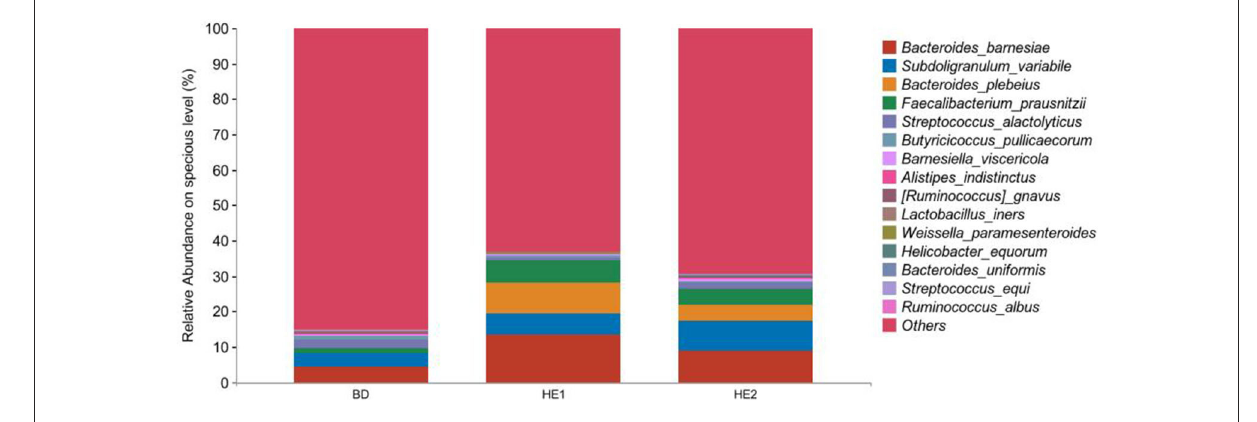
FIGURE3 Relative abundance at the specious level between groups.